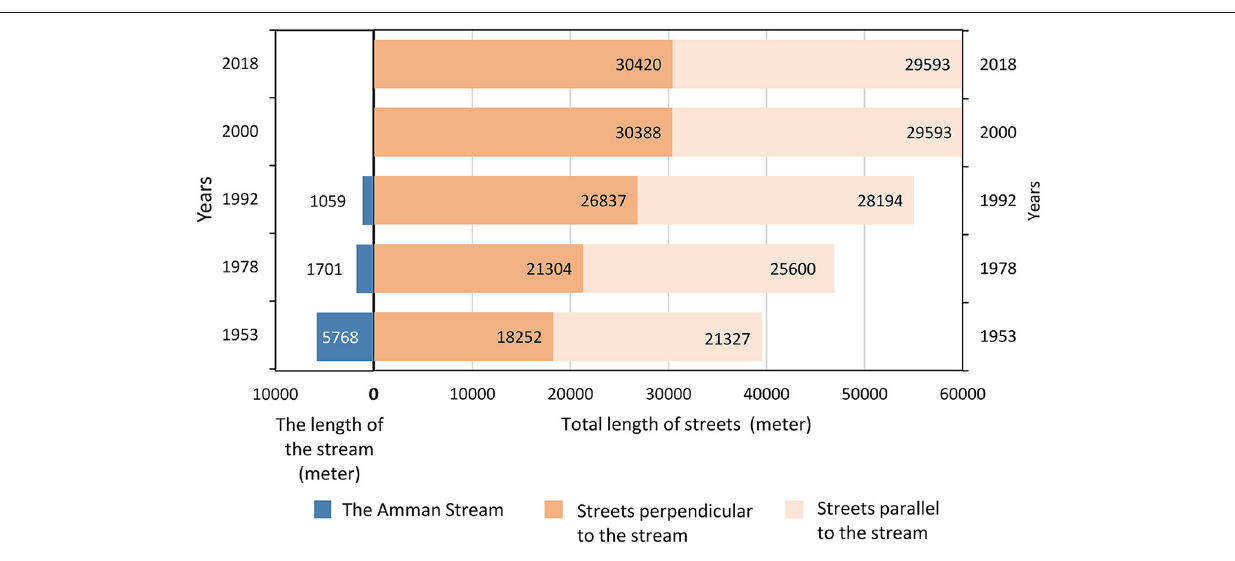
culverting, but by 1992 only one bridge had remained, which was demolished during the second phase of culverting in